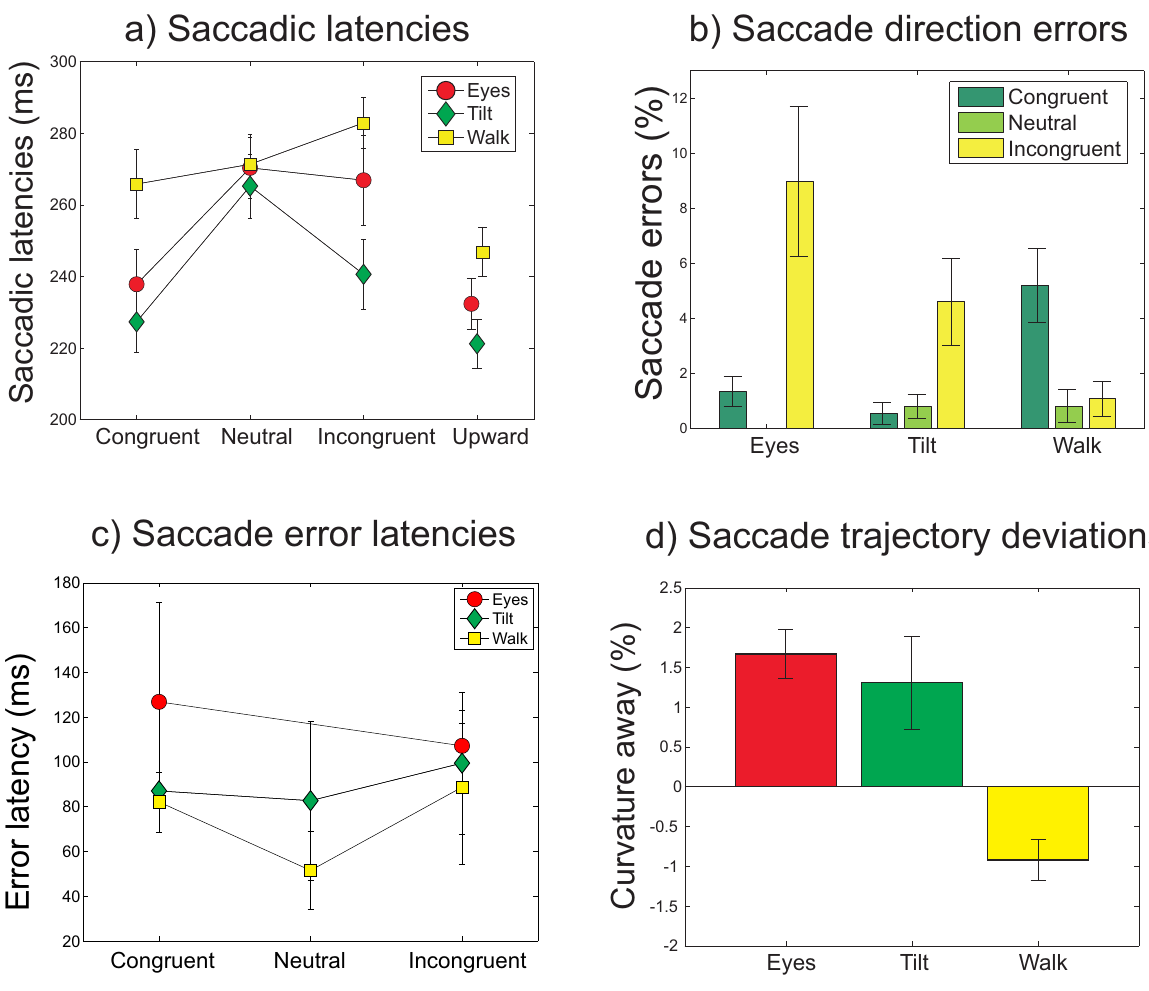
Figure 2 . a) Mean saccadic latencies towards the peripheral target. The data points on the left show the latencies for horizontal saccades, the separate data points on the right show latencies for vertical saccades. The three different symbols (circles, dia- monds, squares) show the data for the different types of video clips (‘eyes’, ‘tilt’, ‘walk’). b) Percentage saccade errors (i.e., a saccade not in the direction of the target) for the different cue-target congruency conditions and movement types. c) Median saccadic latencies of the saccade direction errors across the different conditions. Please note that the data points other than the incongruent ‘eyes’ and ‘tilt’ and congruent ‘walk’ conditions are based on few observations. d) Saccade trajectory devia- tions away (positive values) from and towards (negative values) the movement direction of the cue for the different cues (eye movements, head tilt, and walking past). These deviations are computed with respect to the baseline condition (no-movement condition) and expressed as a percentage of the amplitude of the saccade. The error bars in the different subplots show the standard error of the mean across the 23 participants in the